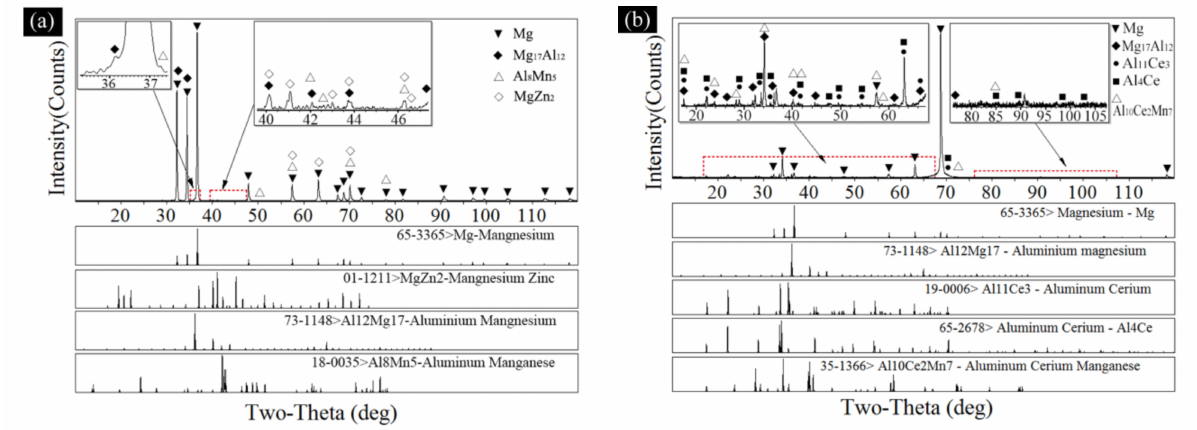
Figure 6. Composition of the alloys ( a ) matrix magnesium alloy ( b ) magnesium alloy with 0.8 wt.%